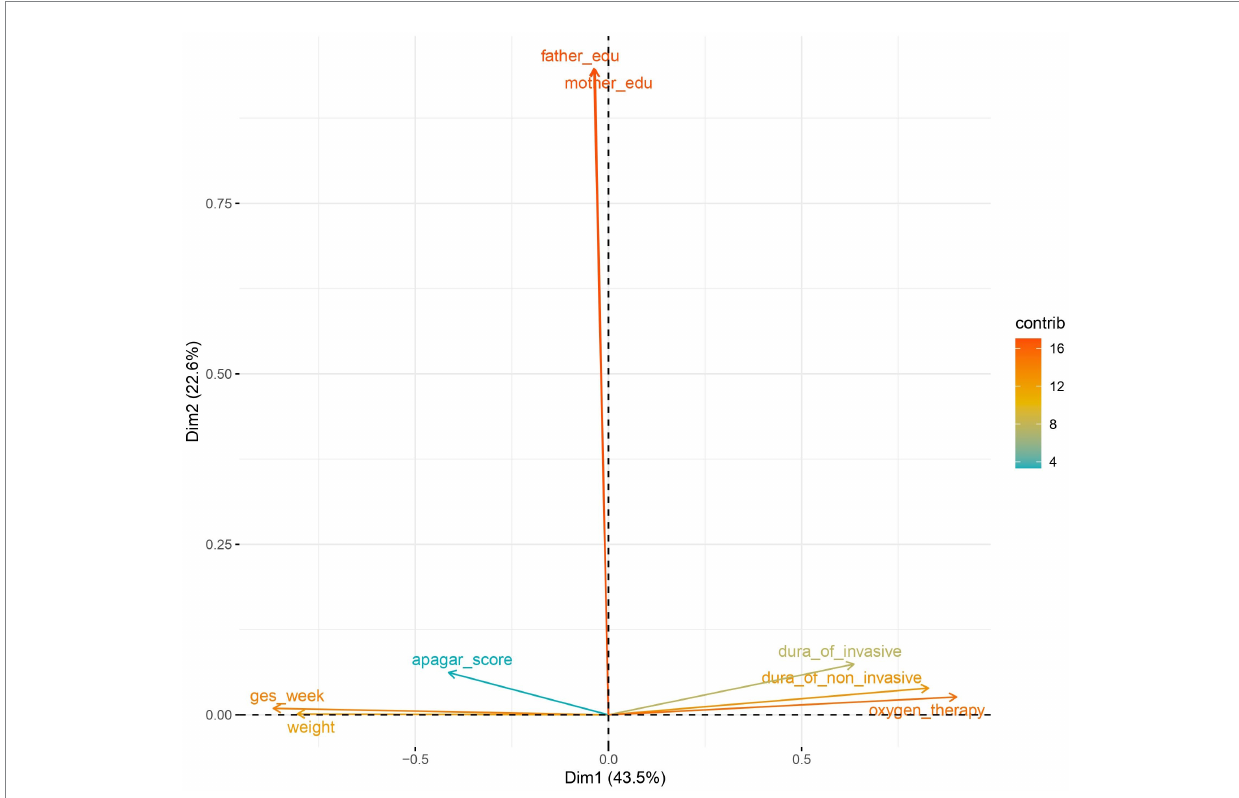
FIGURE 3 Numerical variables in the two-dimensional plane (principal component analysis) In the two-dimensional plane, you can see those 6 variables such as Gestational week, weight, etc. are mapped to the horizontal dimension more ， mother’s education and father’s education were mapped to a greater extent to the vertical